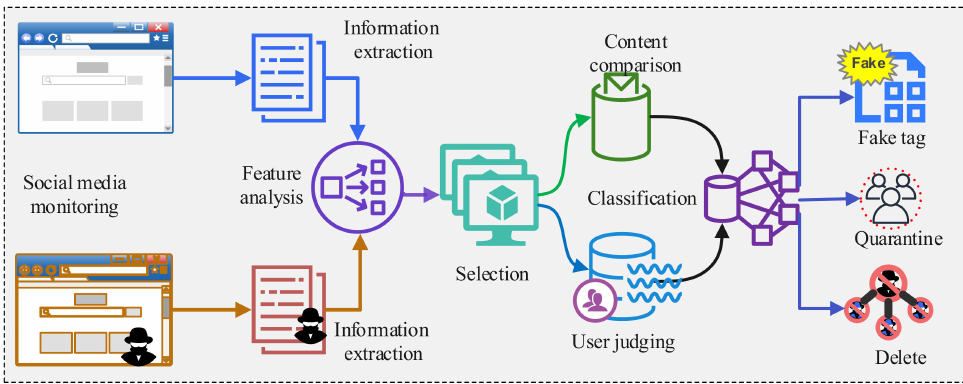
Figure 1. Framework of the proposed fake information containing